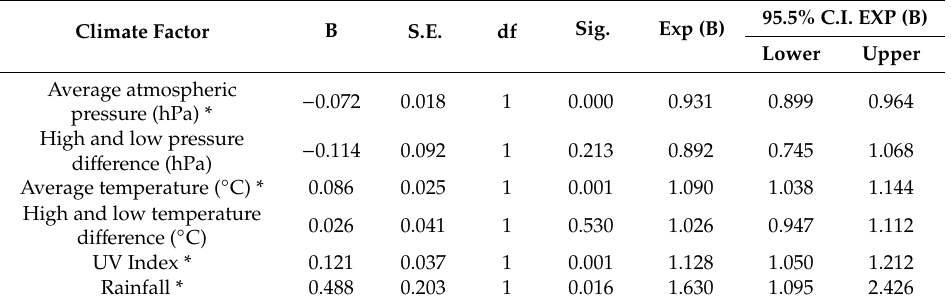
Table 2. Univariate logistic regression analysis on tilapia streptococcosis and climatic